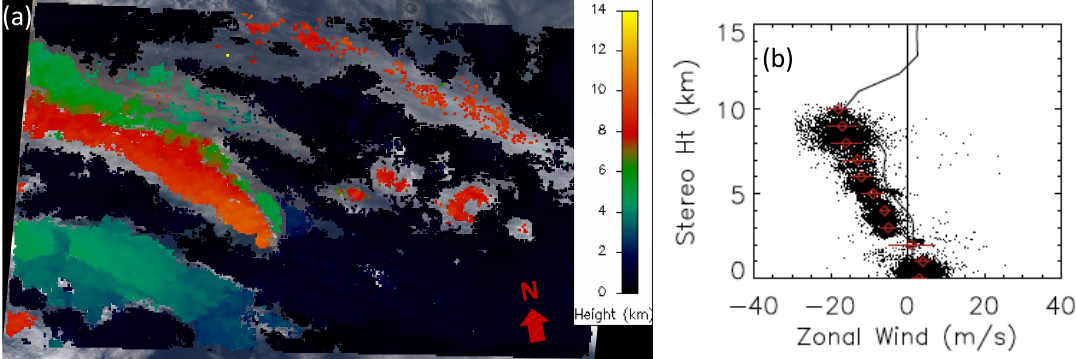
Figure 3. MINX stereo height (ASL) and wind retrievals at 2.2 km resolution for the 16 June plumes/clouds for the same domain shown in Figure 2. The ash tower reached ~10 km under a strong westward wind. The solid line is the MERRA2 zonal wind profile, showing sharp wind shear and reversal from westward to